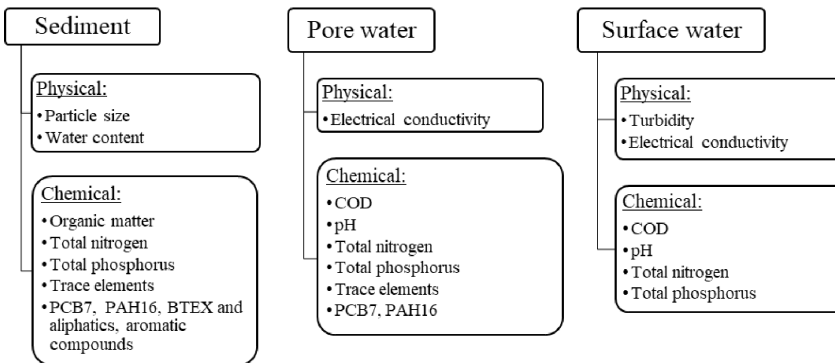
Figure 2. Analyses performed on sediments, pore water and surface